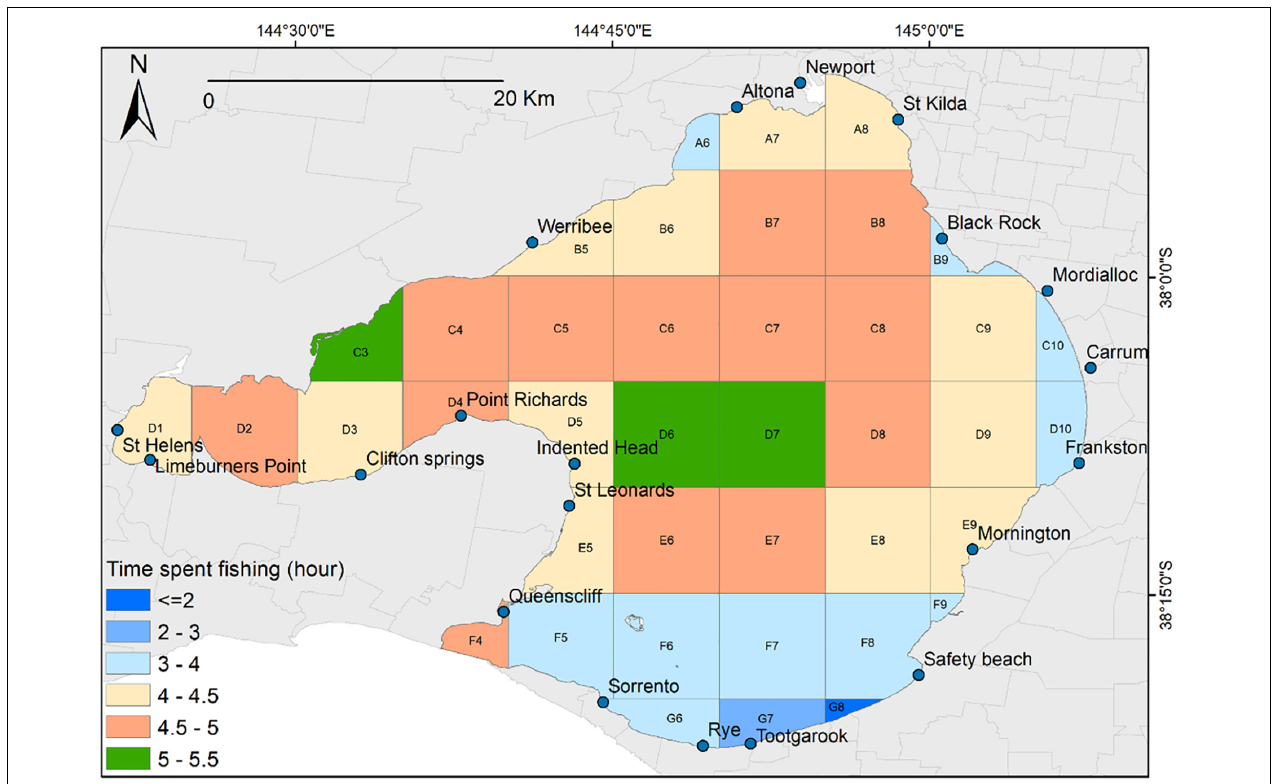
FIGURE 3 | Average amount of time (hours) spent fishing per fishing block in Port Phillip Bay based on the data pooled among years and species.